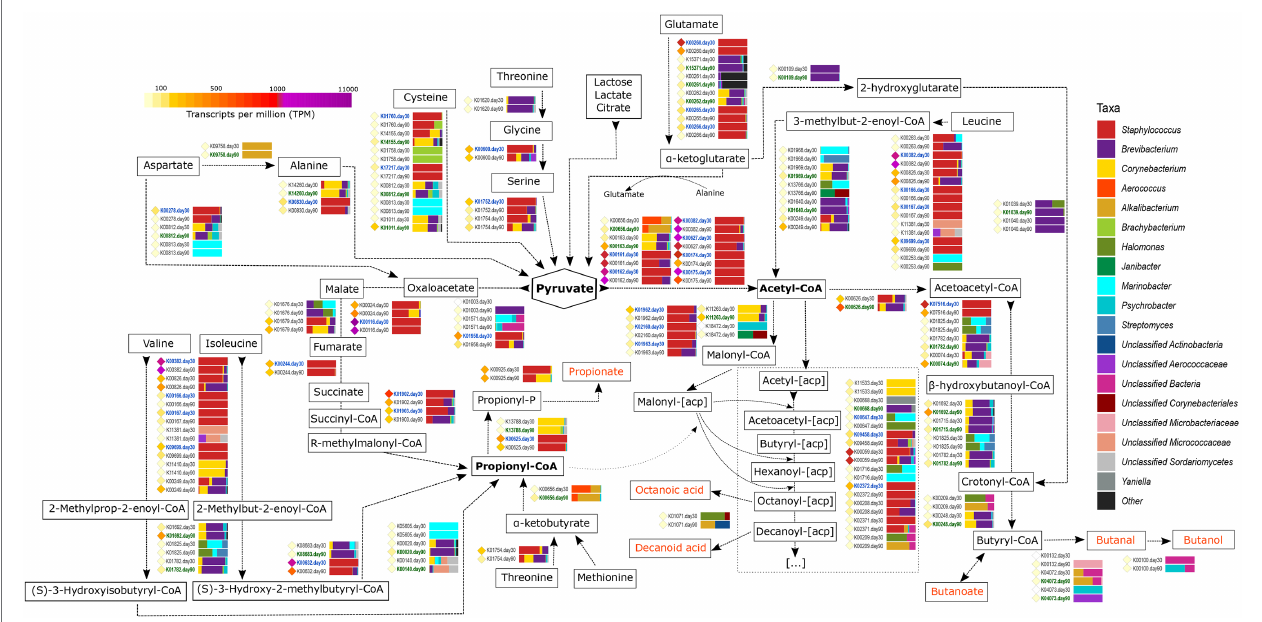
FIGURE 5 | Metabolism of other amino acids and fatty acids. The different compounds that are generated in each metabolic pathway are showed and those harboring important organoleptic properties for cheese are colored in orange. The different metabolic pathways can be followed according to the corresponding arrows. Between every pair of compounds, the genes involved in such reactions are shown with their KO name. TPM values of each gene are shown as colored diamonds next to their corresponding KO name, which is colored in blue or green if significant transcription was identified for such KO day 30 or 90, respectively ( p < 0.05). Next to the KO names, the horizontal bar-plots represent the percentage of transcripts for that KO and ripening time that was associated with the different